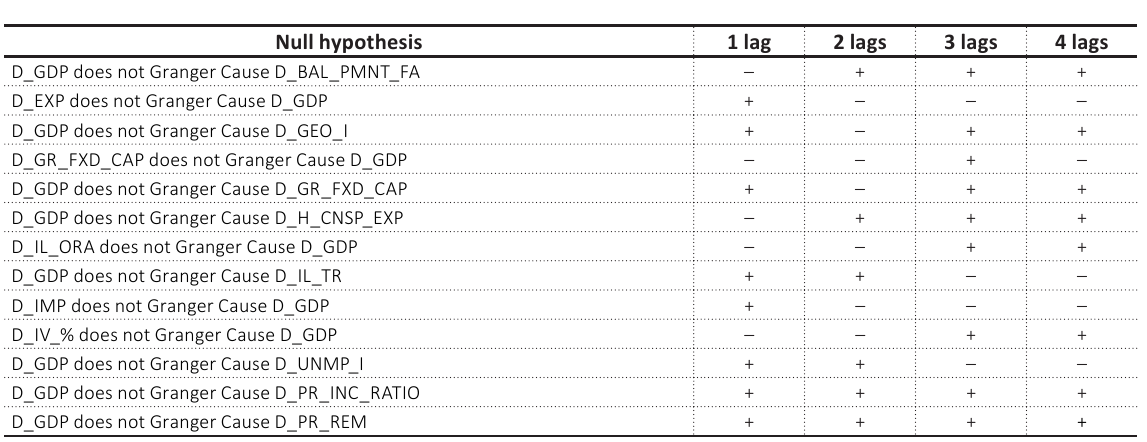
payments (current account), international liquidi- ty (gold), change in the volume of industry